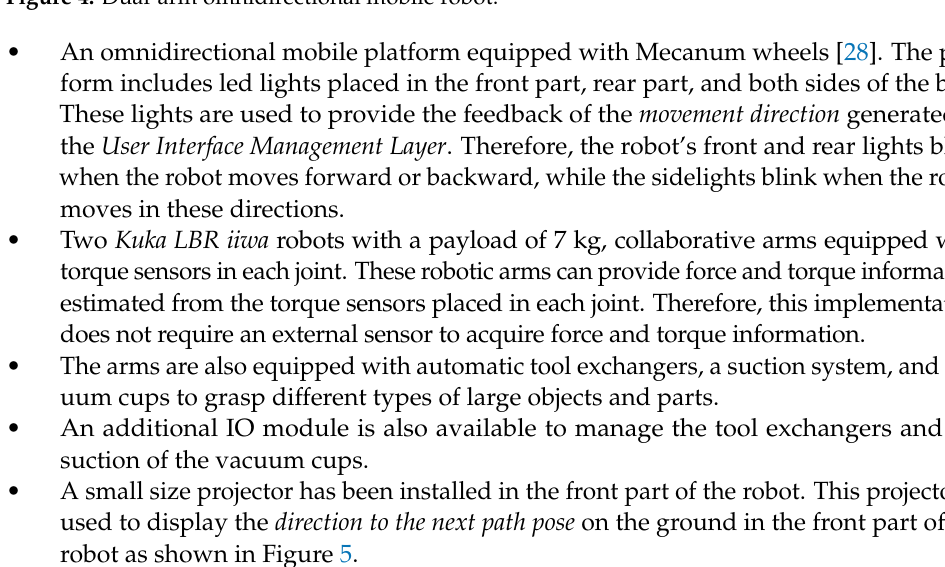
Figure 4. Dual-arm omnidirectional mobile